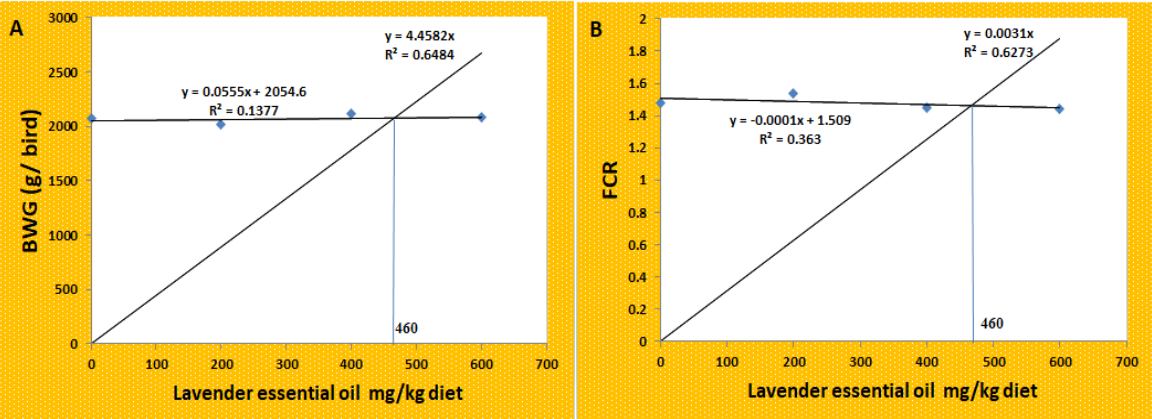
Figure 1. Broken line regression model shows the optimum level of dietary addition of LEO according to the total ( a ) BWG and ( b ) FCR. Table 4. Impact of lavender essential oil addition on the carcass traits (%) relative to live body